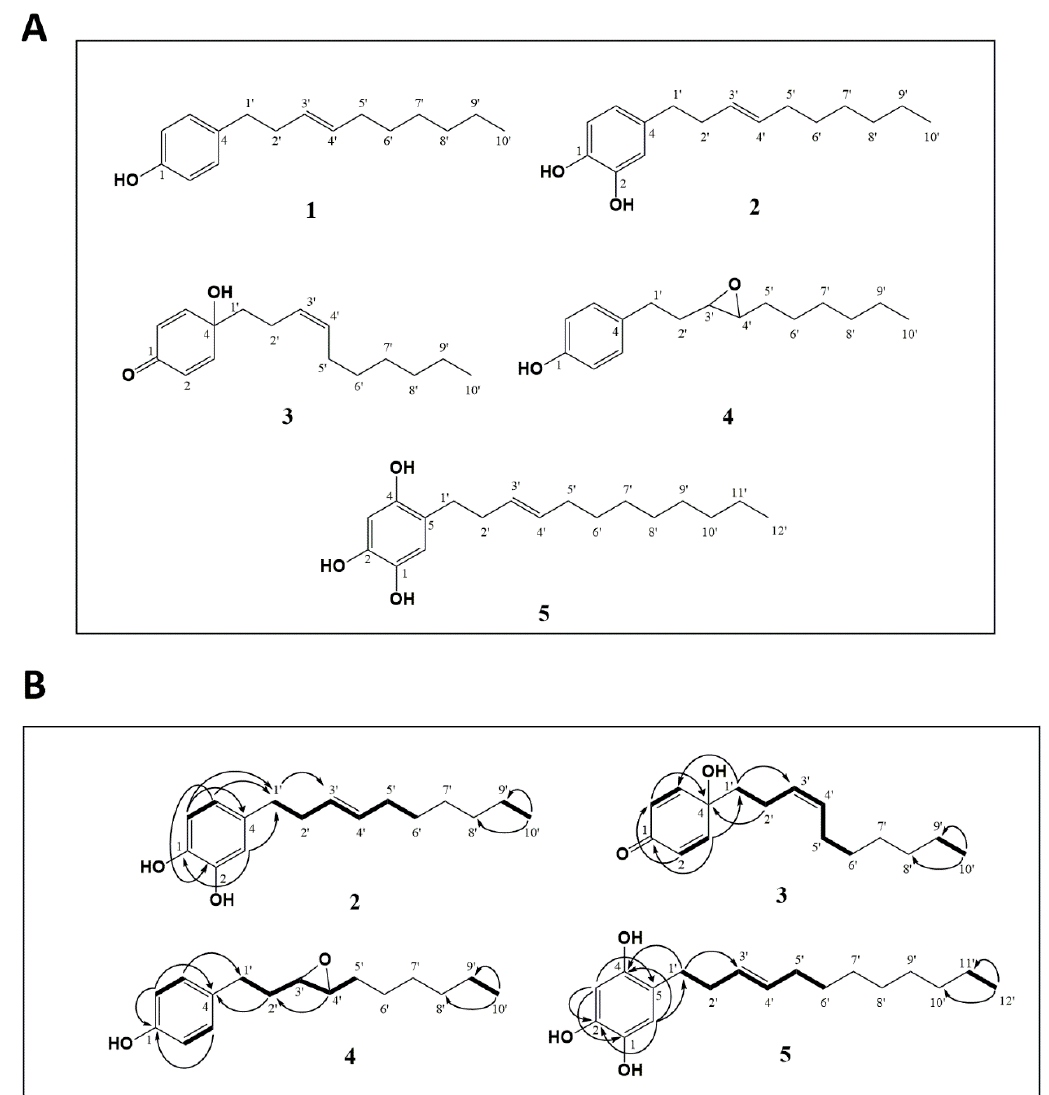
Figure 1. Identification of new Piper genus-derived compounds. ( A ) Structures of compounds 1–5. ( B